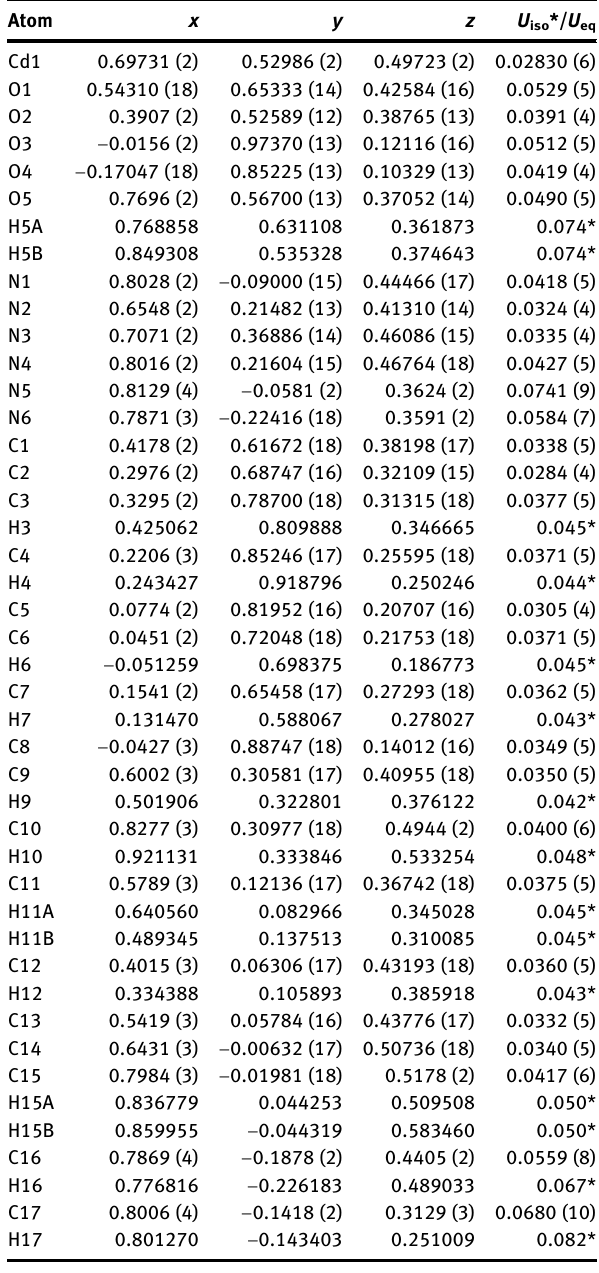
Table  : Fractional atomic coordinates and isotropic or equivalent isotropic displacement parameters (Å 